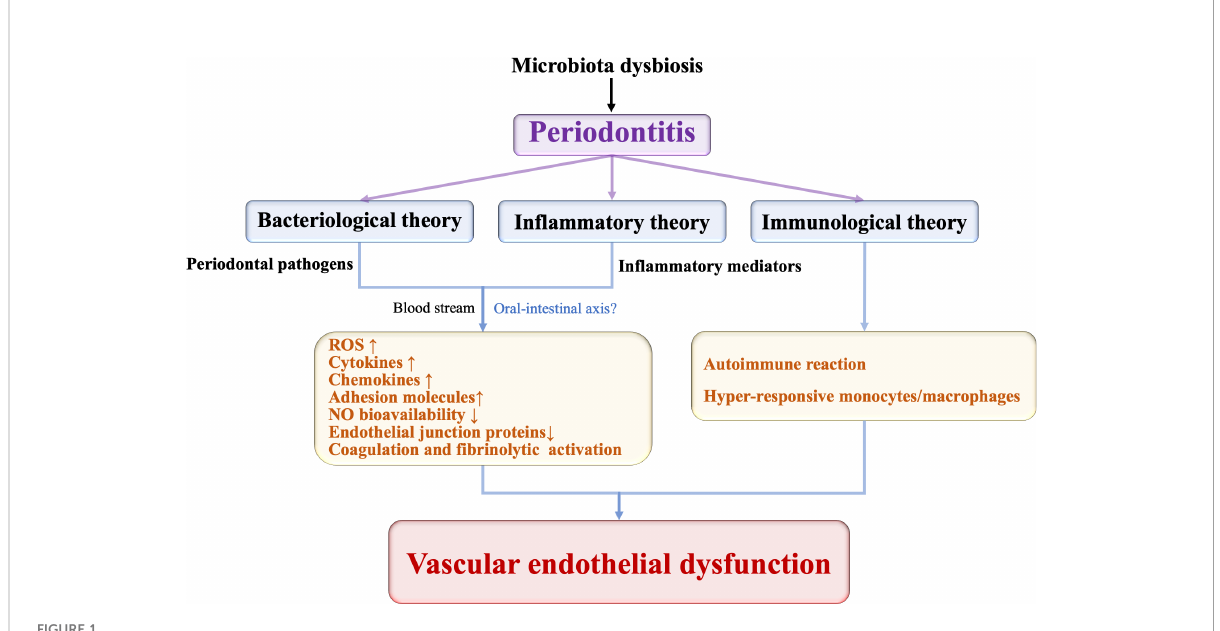
FIGURE 1 The potential pathways periodontitis induces vascular endothelial